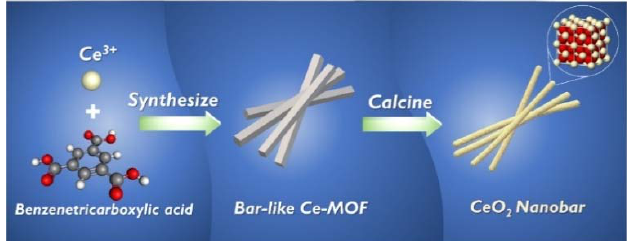
Figure 1. Scheme for preparing bar-like CeO 2 from